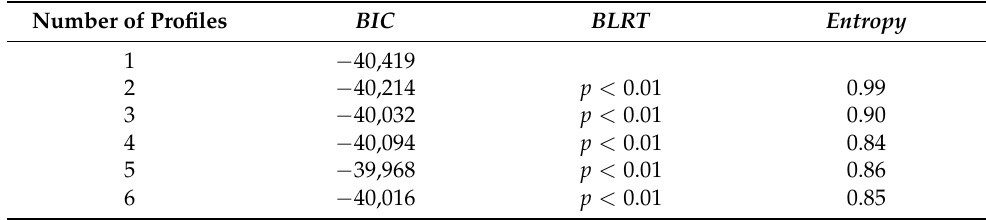
Table 2. Model fit indices of latent profile analysis solutions